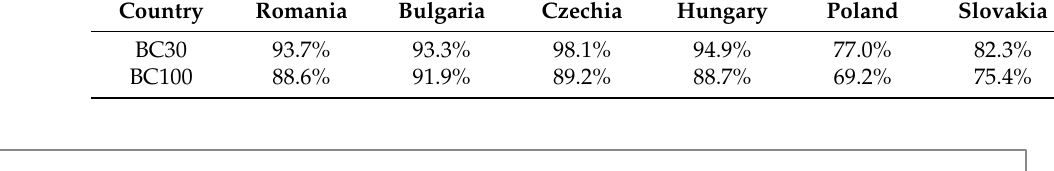
Table 2. Fixed broadband networks coverage by speed in 2021. Country